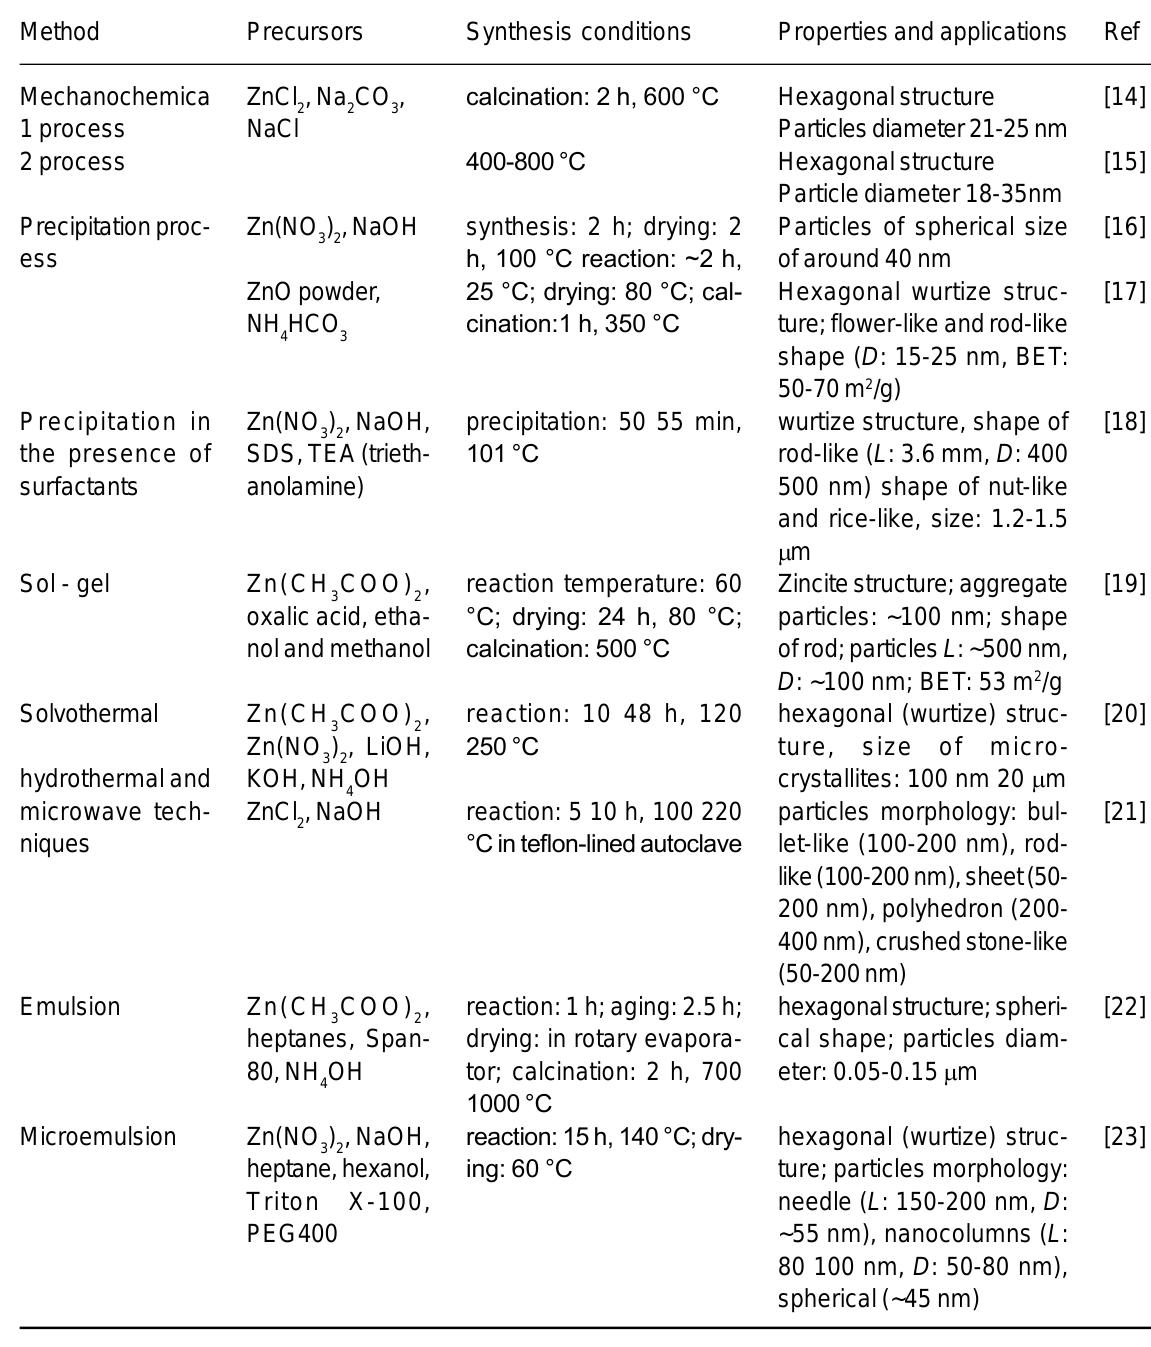
Table 1. Summary of methods of obtaining zinc